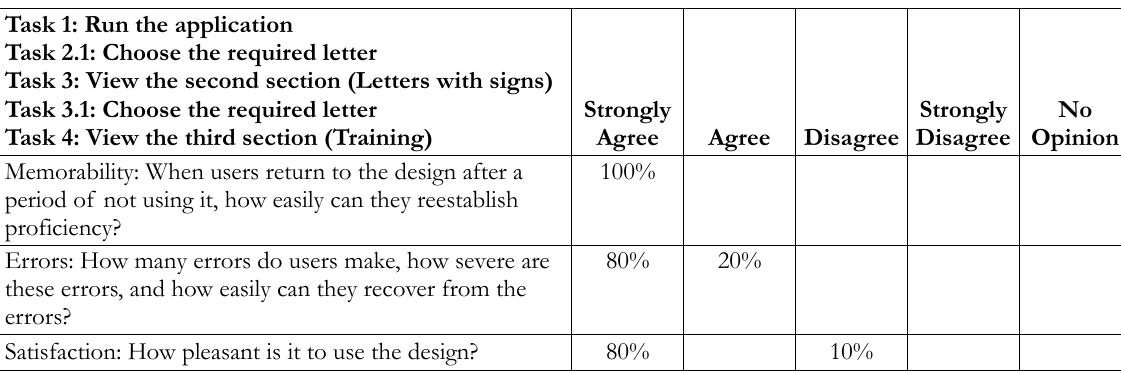
Table 4. The results of the pre-test questionnaire for each task performed by the children